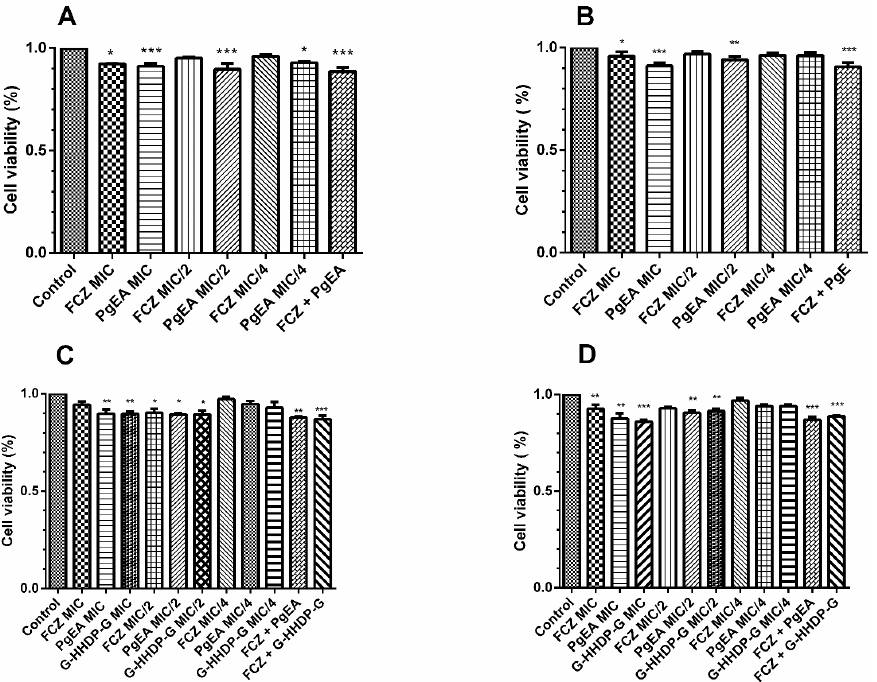
Figure 2. Effect of the ethyl acetate fraction of P. granatum (PgEA), galloyl-HHDP-glucose (G-HHDP-G), and Fluconazole (FCZ) on Candida biofilm formation. ( A ) Effect of PgEA and FCZ on the biofilm formation of the reference strain C. albicans 90028, using inhibitory, sub-inhibitory, and synergistic concentrations. ( B ) Effect of PgEA and FCZ on biofilm formation of the clinical isolate C. albicans CAS, using inhibitory, sub-inhibitory, and synergistic concentrations. ( C ) Effect of PgEA, G-HHDP-G, and FCZ on biofilm formation of the reference strain C. glabrata 2001, using inhibitory, sub-inhibitory, and synergistic concentrations. ( D ) Effect of PgEA, G-HHDP-G, and FCZ on the biofilm formation of the clinical isolate C. glabrata FJF, using inhibitory, sub-inhibitory, and synergistic concentrations. * p < 0.05, ** p < 0.01, and *** p < 0.0001. Data represent the mean ± SD of three independent experiments carried out in triplicate.